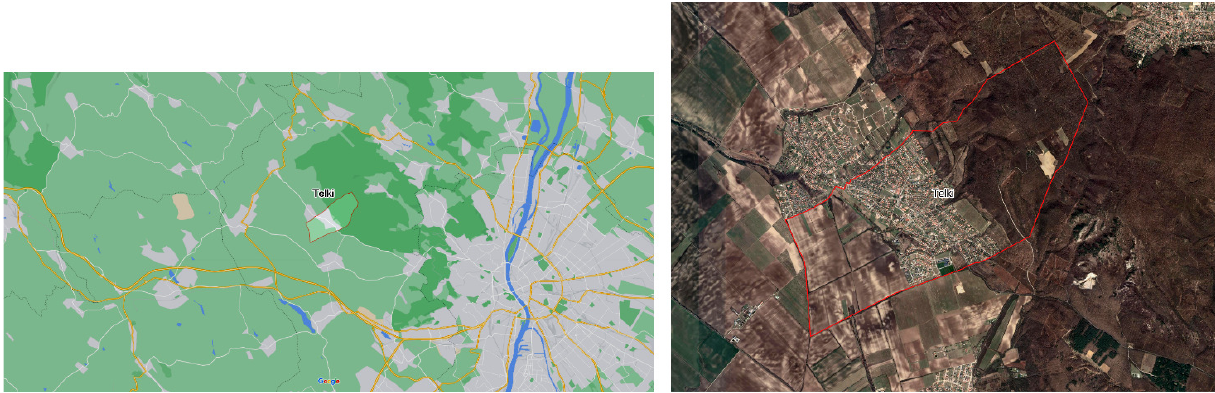
Figure 2. Geographical location of Telki. Source: Google